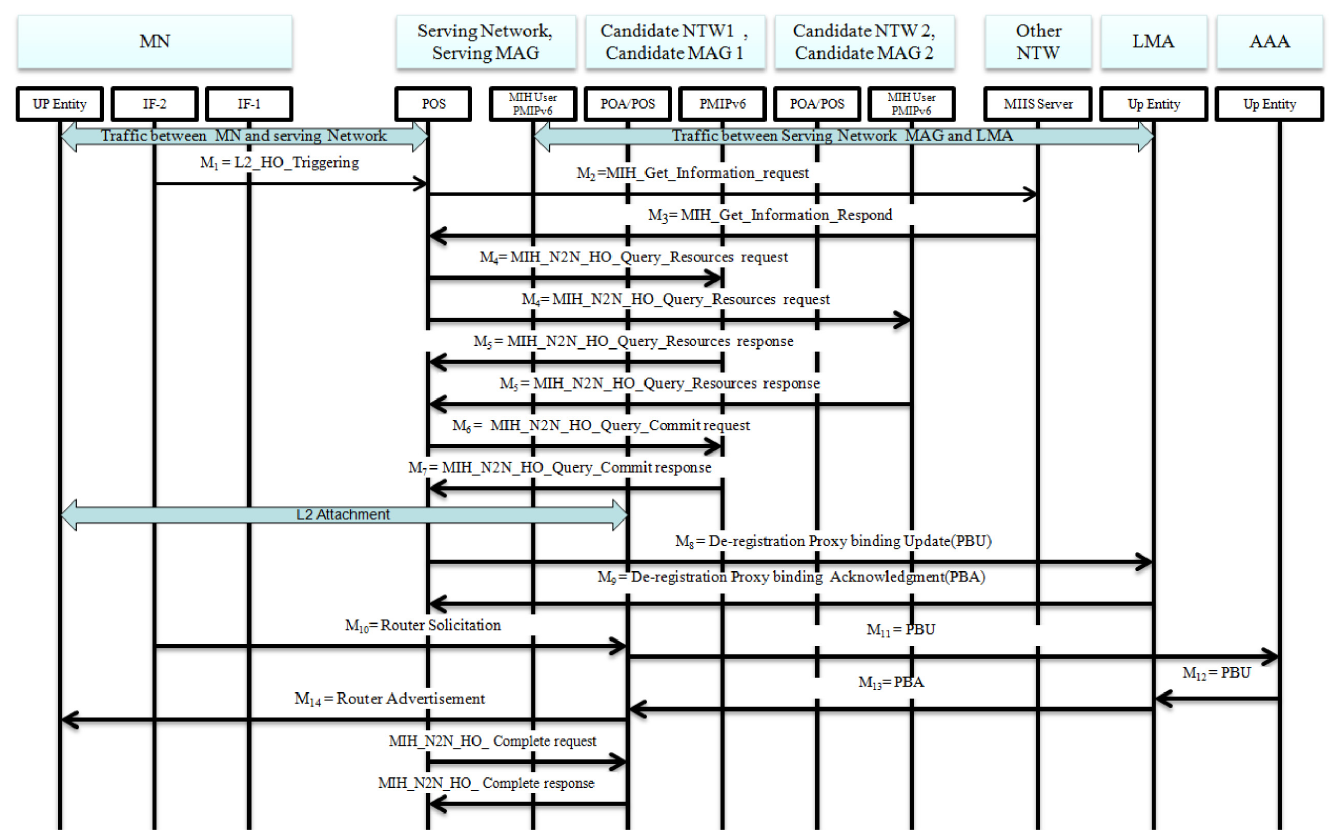
Fig 2. MIH-based PMIPv6 handover